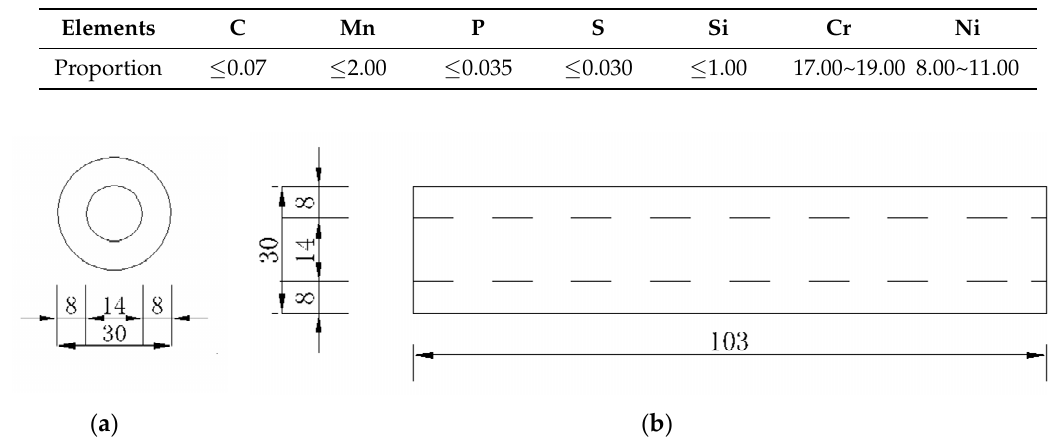
Table 1. The content of trace elements in specimens.